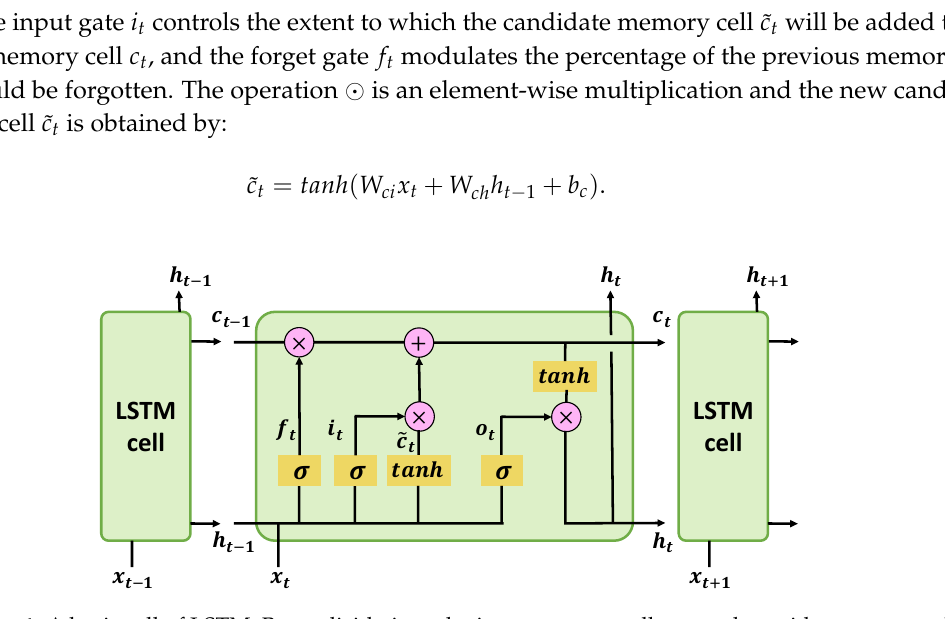
Figure 1. A basic cell of LSTM. By explicitly introducing a memory cell c t together with some control gates f t , i t and o t to decide the information flow, LSTM can capture long-term dependencies of the sequential